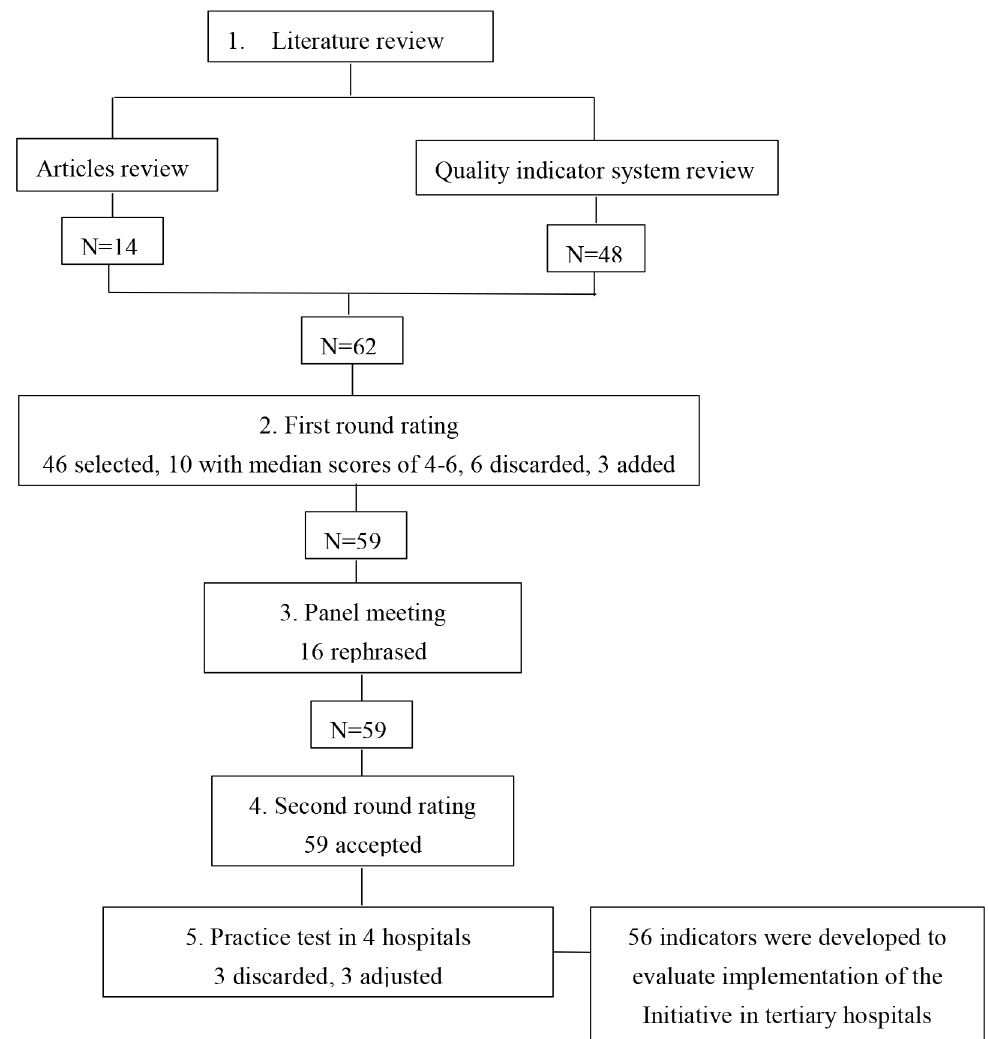
Fig 2. Flowchart of indicator development and resulting inclusion and exclusion of